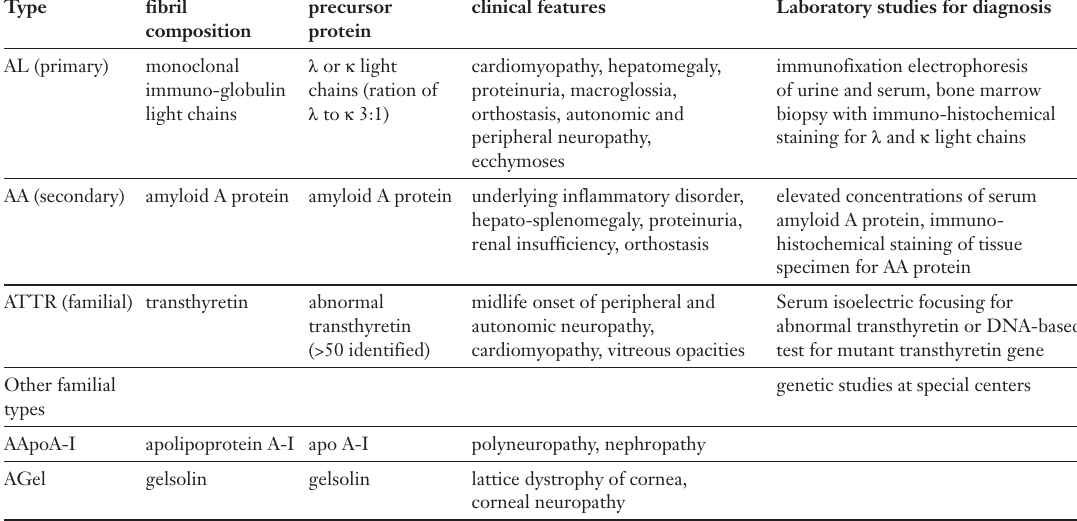
No financial support